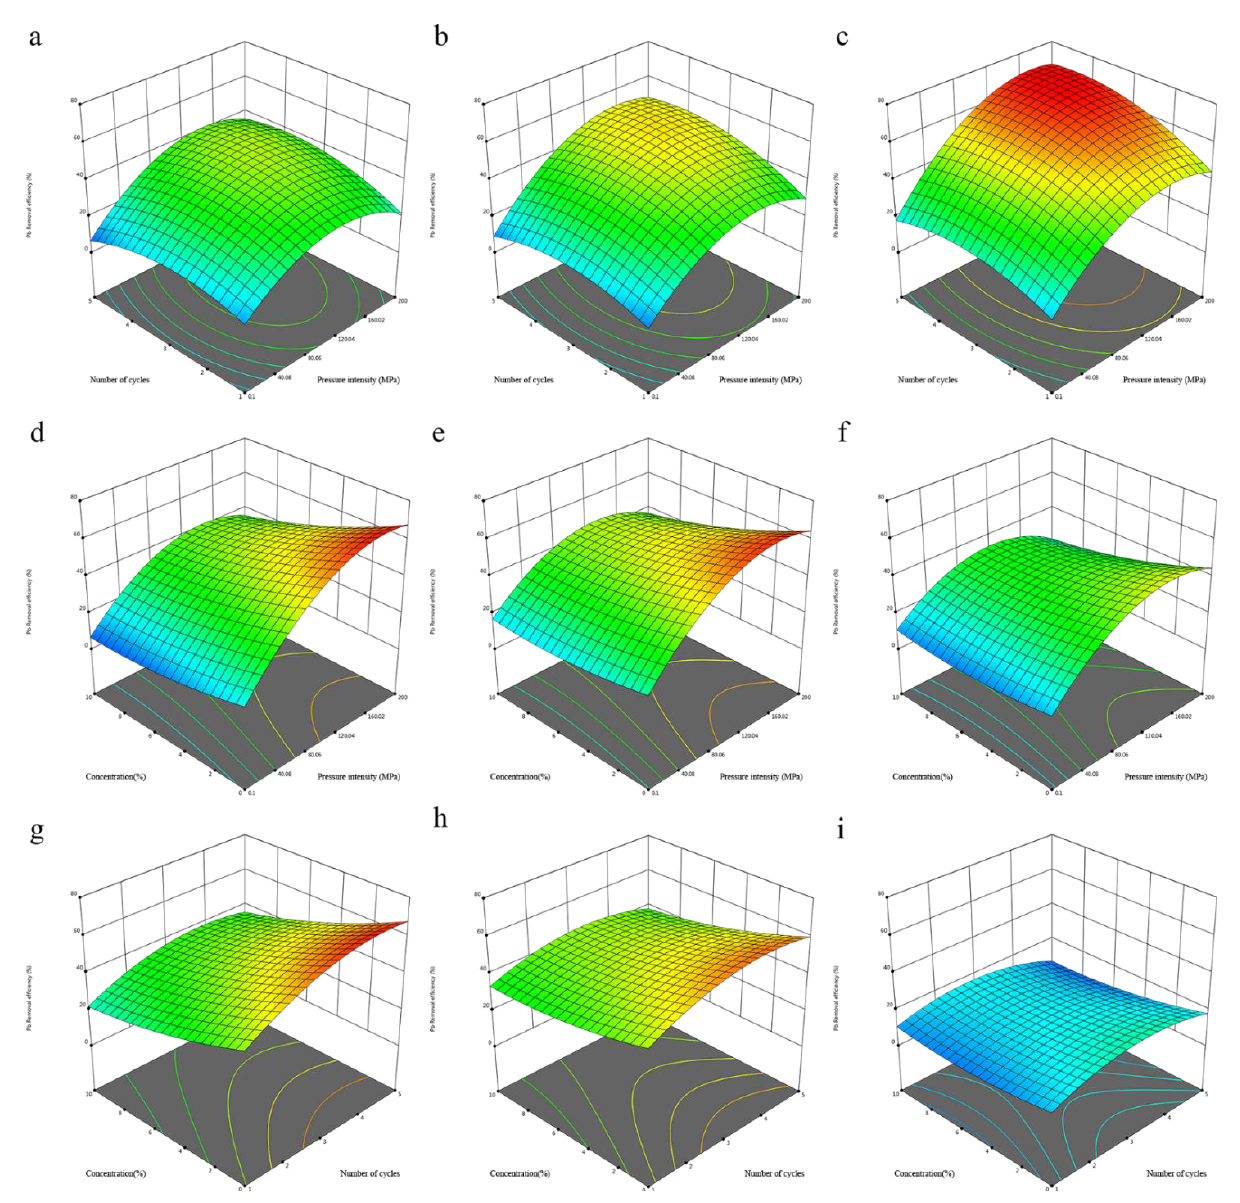
Figure 1. Three-dimensional surface plots showing interaction effects of independent variables on the Pb removal efficiency: ( a ) pressure intensity–number of cycles, effect at concentration of 10%; ( b ) pressure intensity–number of cycles, effect at concentration of 5%; ( c ) pressure intensity–number of cycles, effect at concentration of 0%; ( d ) pressure intensity–concentration, effect at 5 cycles; ( e ) pressure intensity–concentration, effect at 3 cycles; ( f ) pressure intensity–concentration, effect at 1 cycle; ( g ) number of cycles–concentration, effect at 200 MPa; ( h ) number of cycles–concentration, effect at 100.05 MPa; ( i ) number of cycles–concentration, effect at 0.1 MPa.